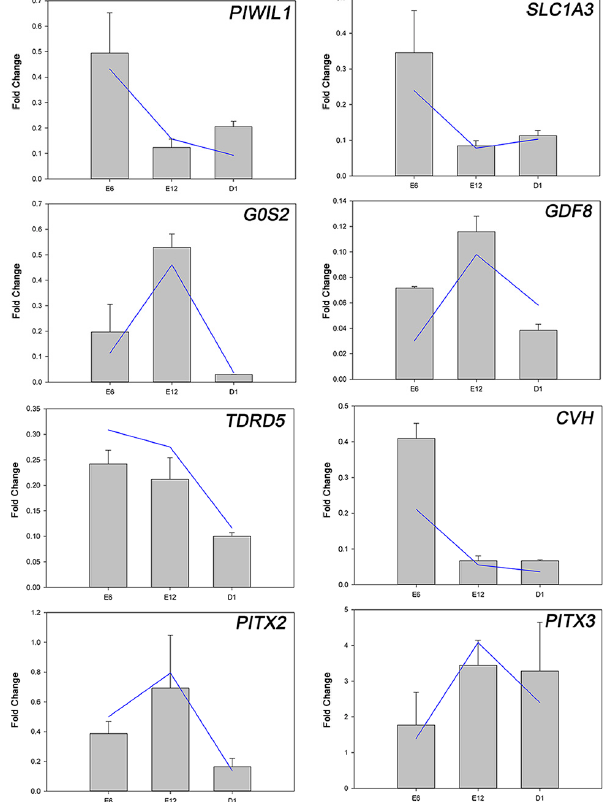
Figure 3. Expression patterns of eight DEGs involved in left-right asymmetry by RNA-seq (blue line) and qRT-PCR (gray bar). The quantitative real-time RT-PCR (qRT-PCR) values were normalized relative to the expression levels of GAPDH in the same cDNA sample. Expression data are presented as the expression values of genes in the right gonads relative to that in the left sample. Data are expressed as the mean ± SD of two biological replicates.